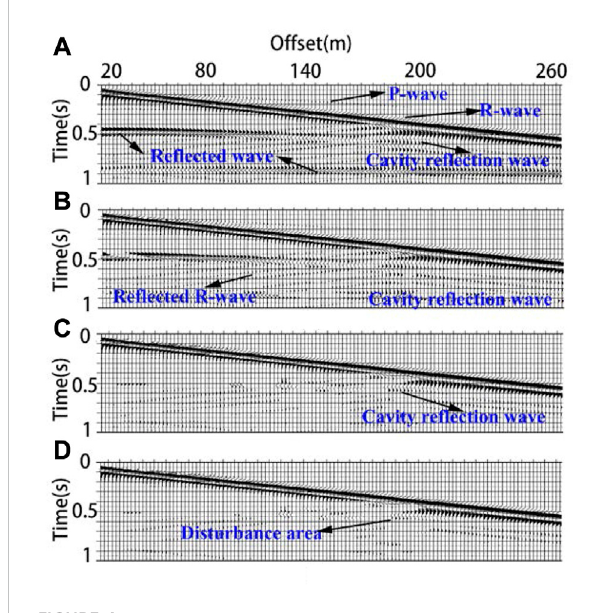
FIGURE 4 Seismic record. (A) is the original signal simulated by the transverse inhomogeneous half-space model; (B – D) are seismic records after polarization fi ltering with parameters of 0.1, 0.3 and 0.4 respectively.